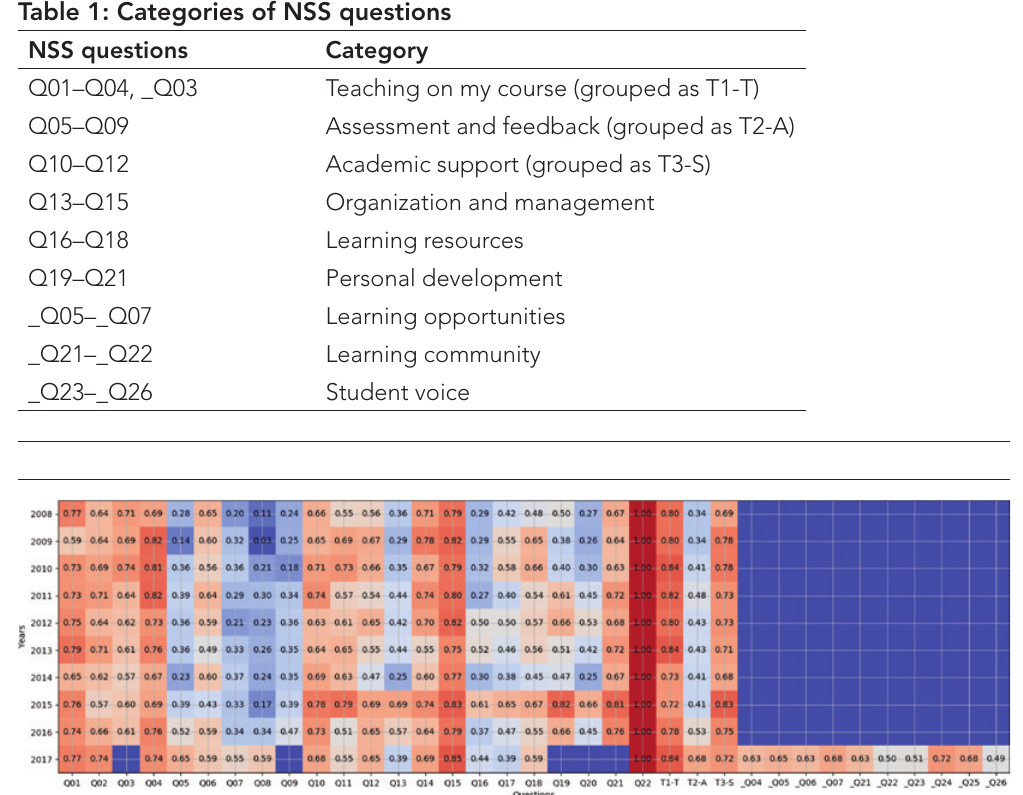
Figure 1: Heat-map of correlations of satisfaction of NSS questions with Q22, in computer science, per year, across all